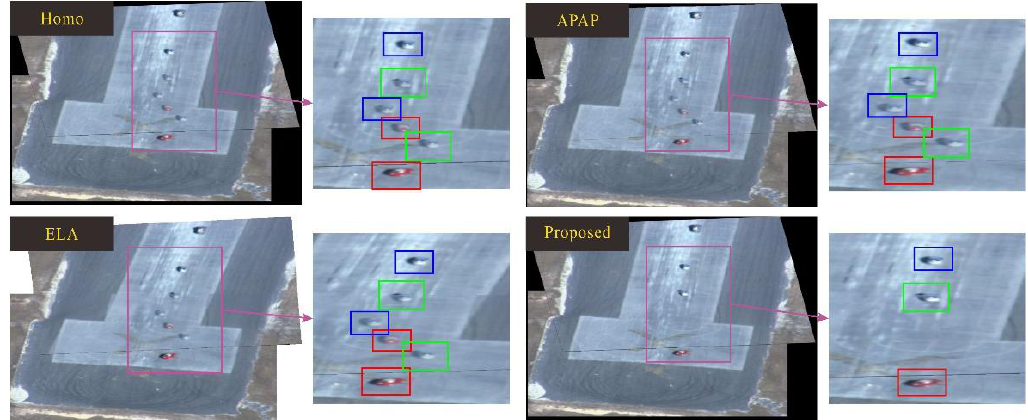
Figure 13. Comparison between the proposed method and SOTA method on eg01 data.